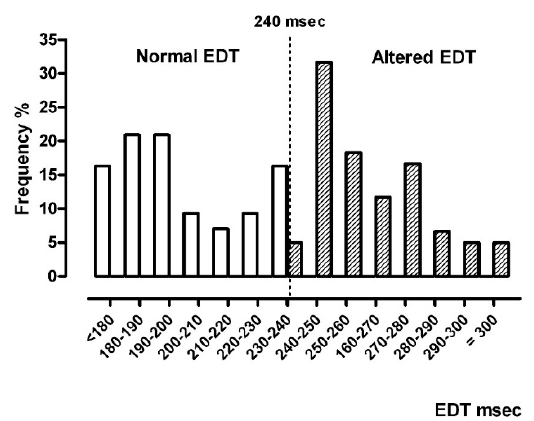
Figure 2. Frequency distribution of EDT values in the EDT classes: normal EDT (white) and altered EDT (shadow). Legend: EDT = trans-tricuspid E-wave deceleration time.